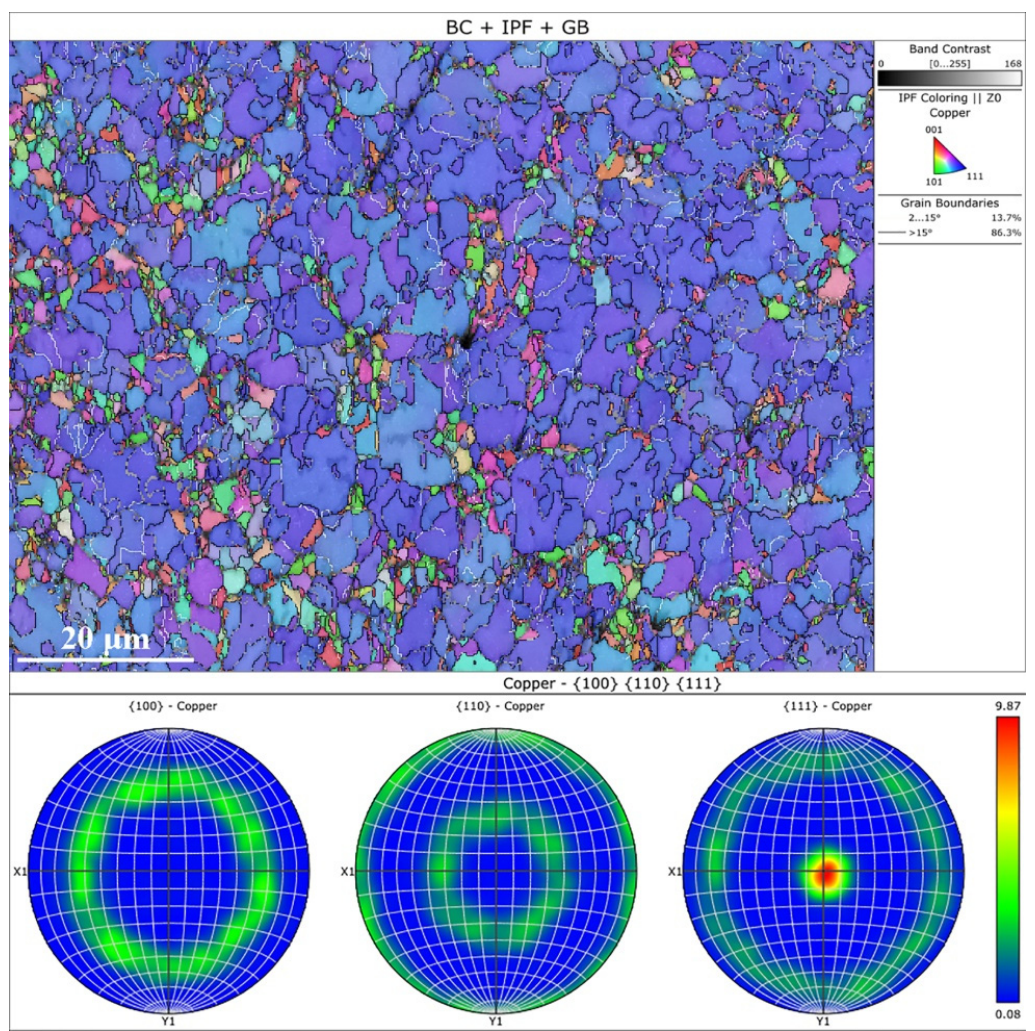
Figure 7. EBSD orientation maps (TD), grain boundary and the pole figure of Cu electrodeposition in